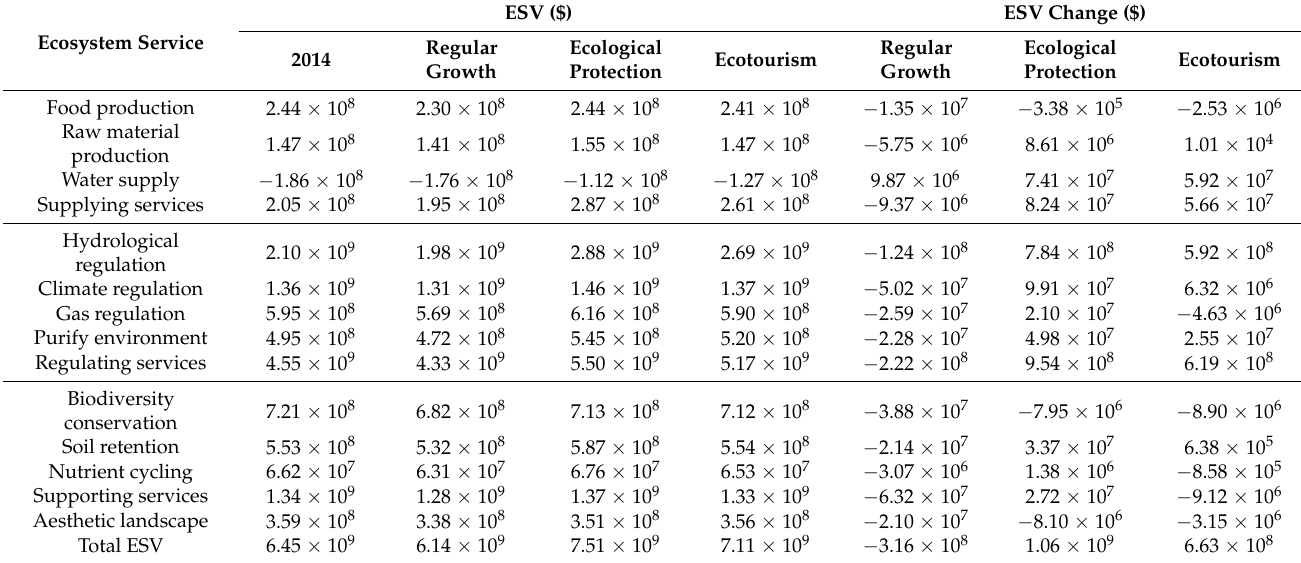
Table 8. Ecosystem service value ($) in 2030 and the ecosystem service value change ($) from 2014 to 2030 for three scenarios.